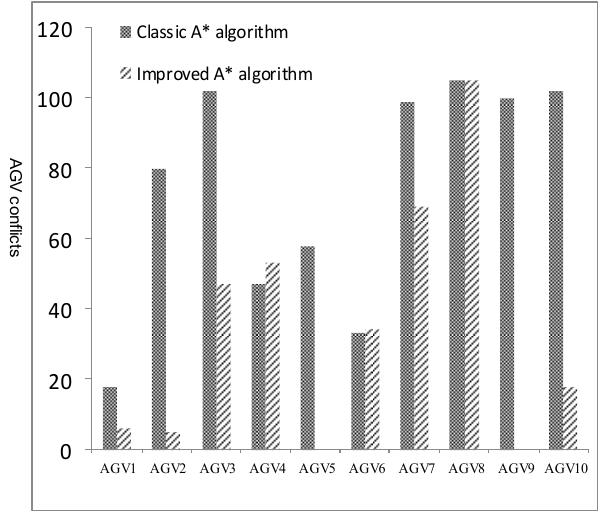
Figure 10. Conflicts comparison chart.